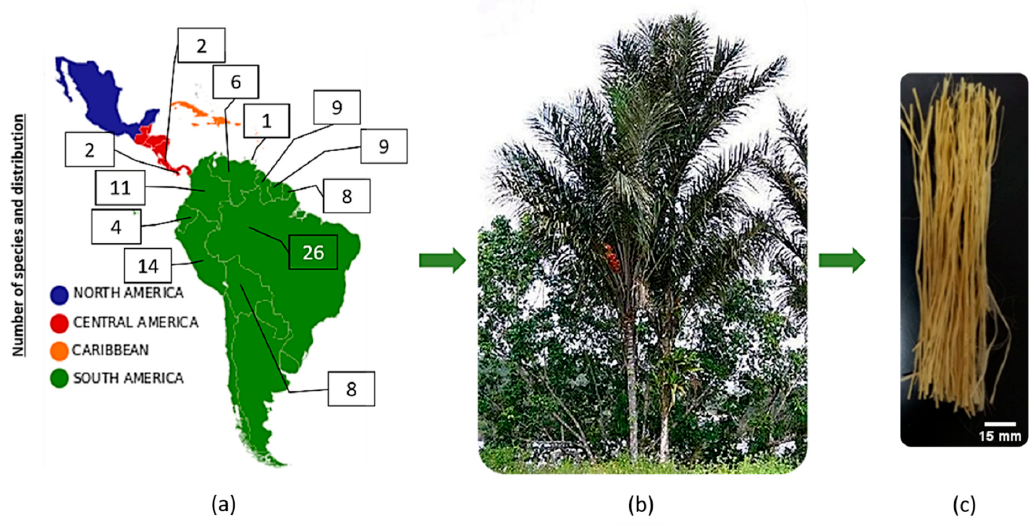
Figure 1. The palm genus Astrocaryum endemic in ( a ) South America and Central America, ( b ) Tucum palm tree and ( c ) fiber ( Astrocaryum vulgare chosen for present work).